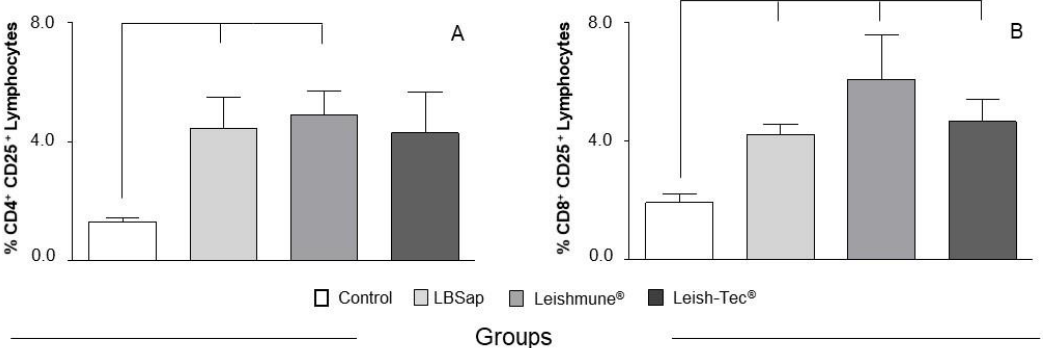
( p < 0.05) in the percentage of CD8 + CD25 + T cell population in all vaccine groups (LBSap, Leishmune ® ,